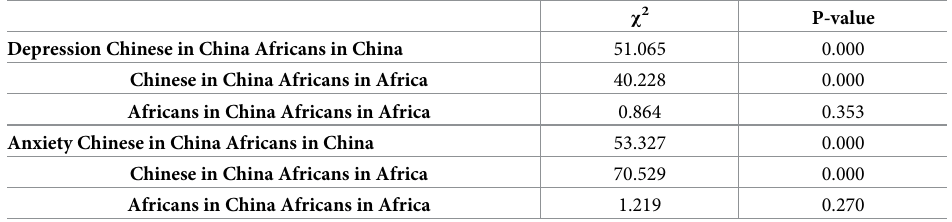
Table 8. χ 2 test of significant differences in depression and anxiety levels between all groups.